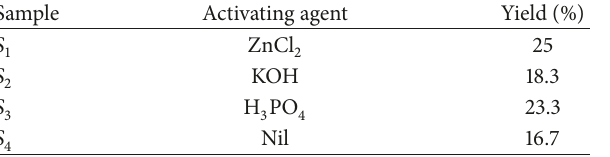
Table 3: Effect of activating agent on activated carbon yield. Sample